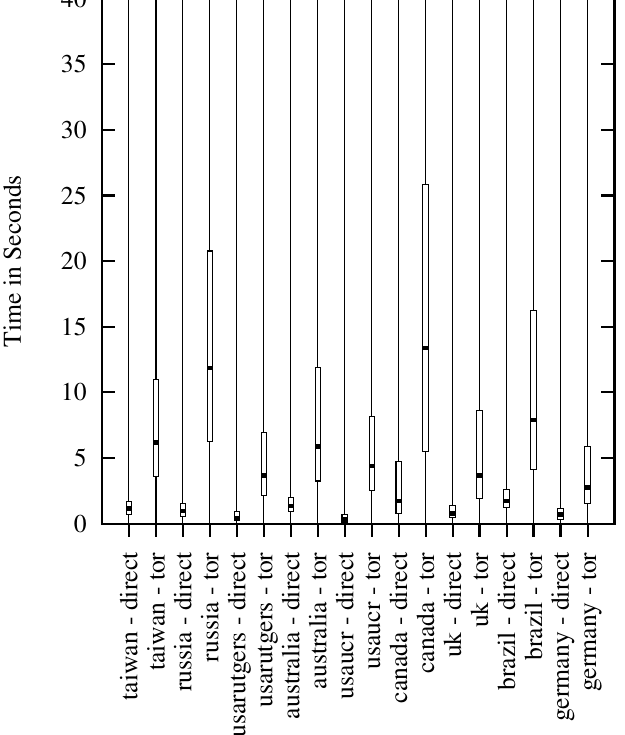
Figure 4. Averages of Core Latency for HTTP